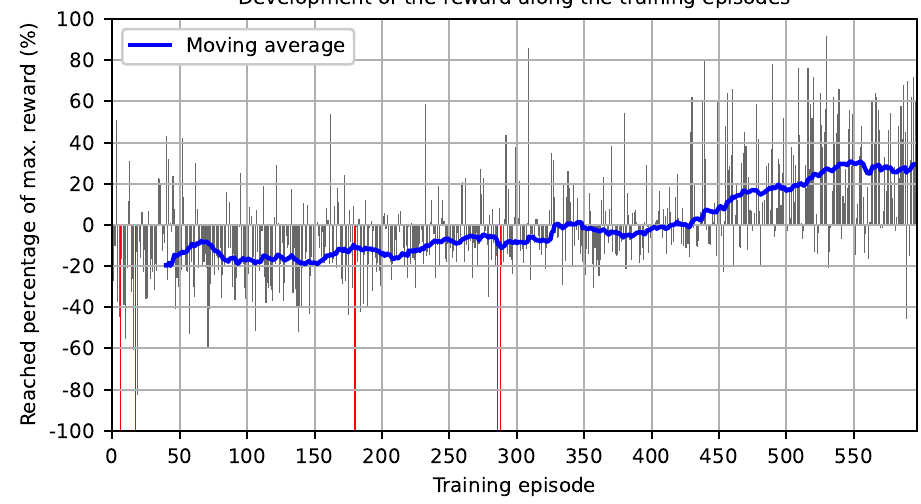
Figure 7. The average reward per iteration over the training increases